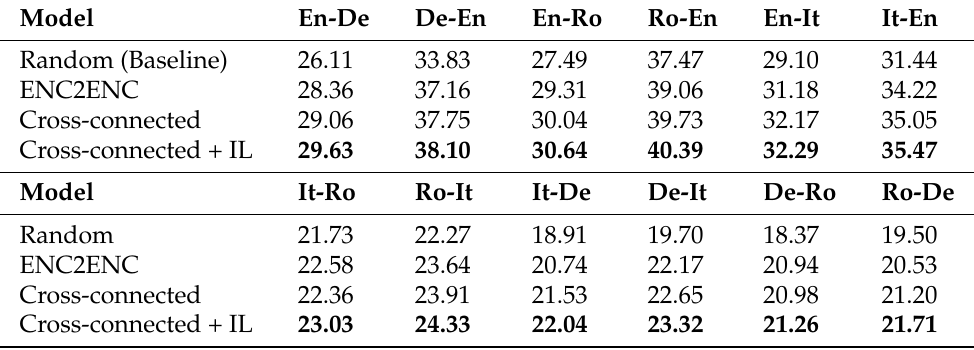
Table 2. BLEU scores for the IWSLT14 En-De, IWSLT14 En-Ro, IWSLT14 En-It, and IWSLT17 It-Ro datasets. IL is the intermediate layer and its configuration is different for each model. We indicate the best scores with bold